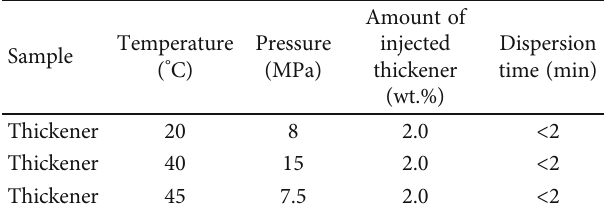
Table 7: Results of the sample dispersion